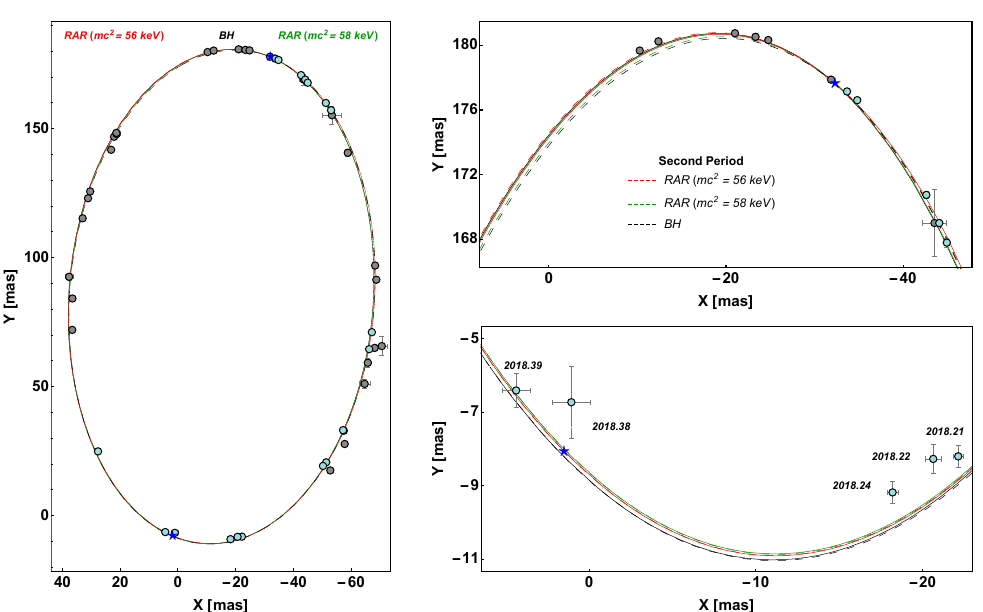
Figure 7. Relativistic precession of S2 in the projected orbit on the plane of the sky, predicted in the BH and RAR DM models. While it is prograde for the BH and RAR ( mc 2 = 58 keV) (in dashed black and green, respectively), it is retrograde for the RAR DM model ( mc 2 = 56 keV) (in dashed red). The solid (theoretical) curves and grey (data) points correspond to the first period ( ≈ 1994–2010), while the dashed (theoretical) curves and cyan (data) points to the second period ( ≈ 2010–2026). Right panels : zoom of the region around apocenter (top panel) and pericenter (bottom panel) . Reproduced from [36] with the authors’